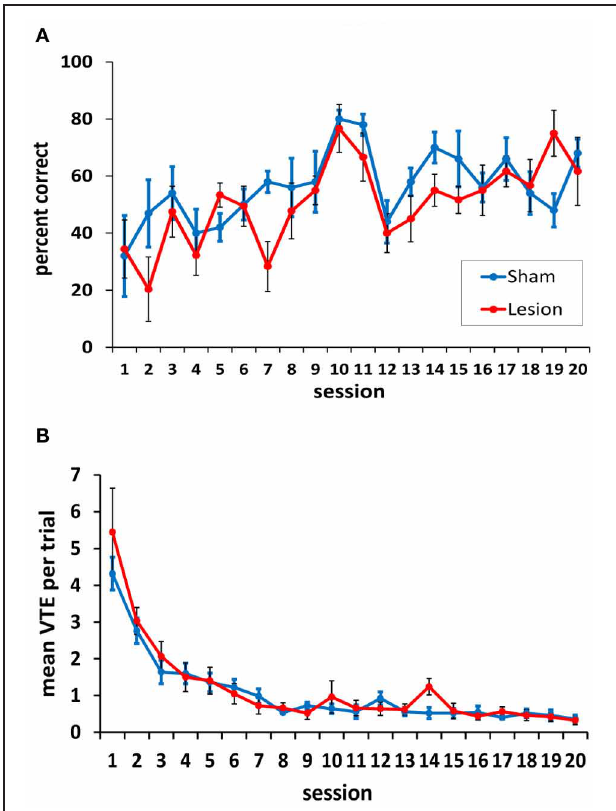
FIGURE 7 | Performance on the two-choice visual discrimination task. (A) Both animals with hippocampus damage and sham lesions acquired the visual discrimination, and the two groups did not differ in this acquisition. (B) Both the hippocampus- and the sham-lesioned animals showed more VTE behavior in the initial training sessions compared to the subsequent sessions. No differences between the two groups were observed in